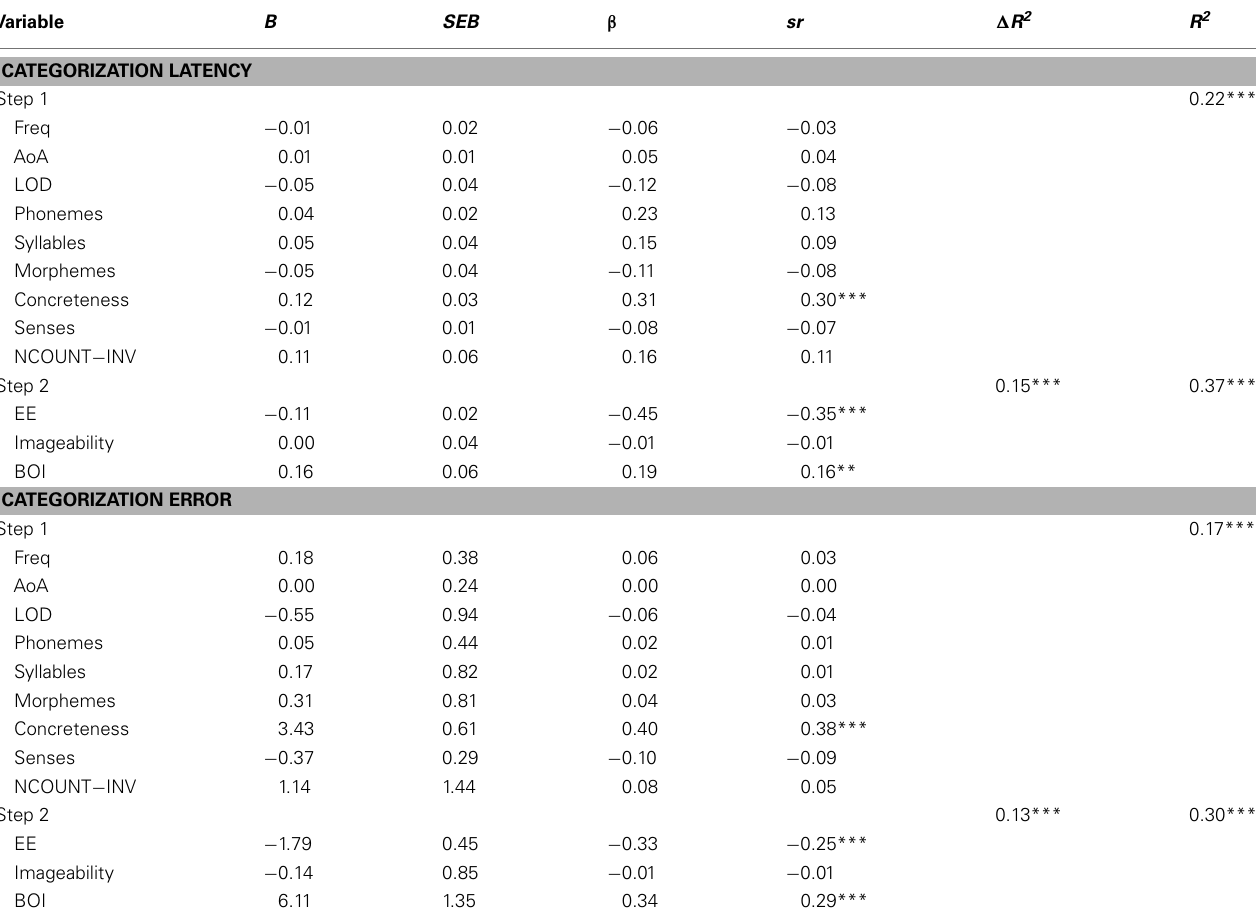
Table 6 | Results of hierarchical multiple regression analyses for the abstract